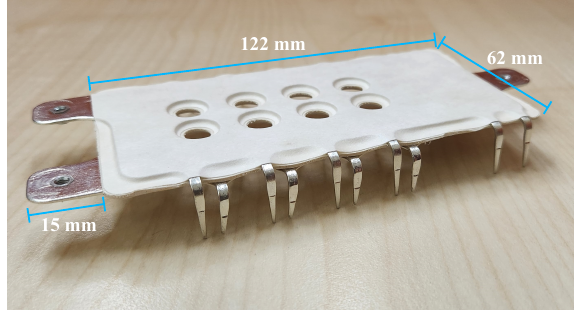
Figure 7. Laminated